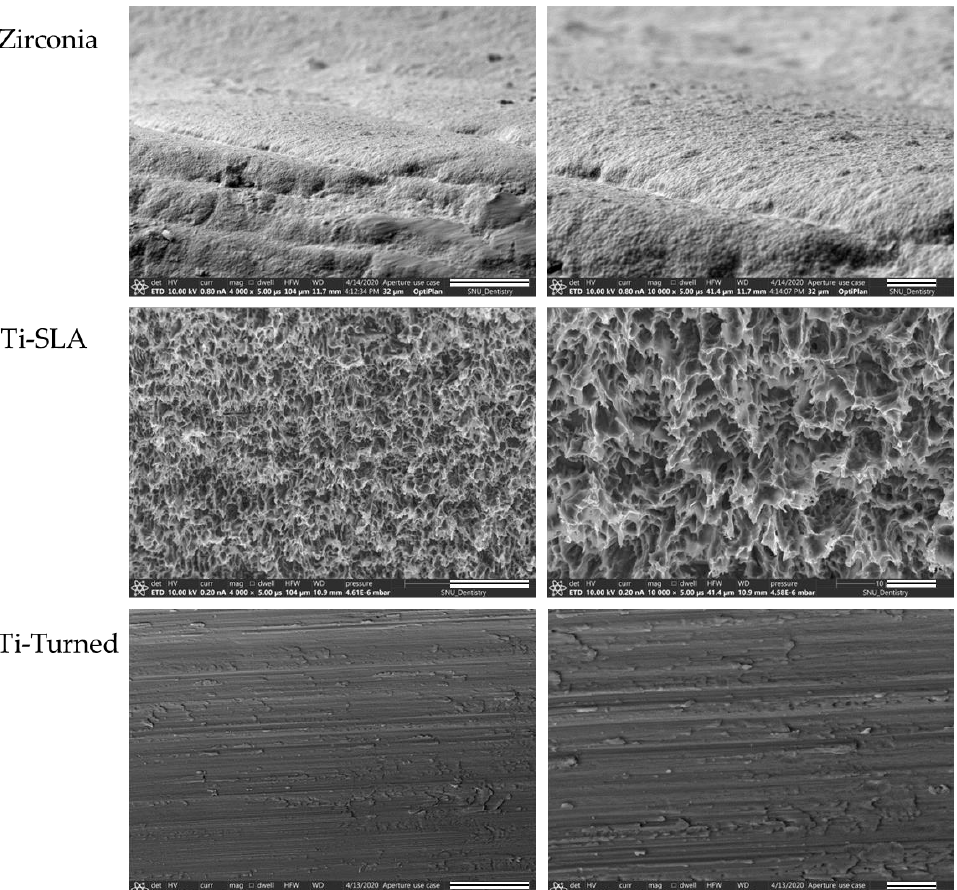
Figure 1. Field emission scanning electron microscopy (SEM) images of zirconia (top), Ti-SLA (middle), and Ti-turned implants (bottom) (magnification: ×4000 (scale bars, 20 μm) and ×10,000 (scale bars, 5 μm) from the left). Images demonstrated different surface morphologies among the Zirconia, the Ti-turned, and Ti-SLA implant surfaces.